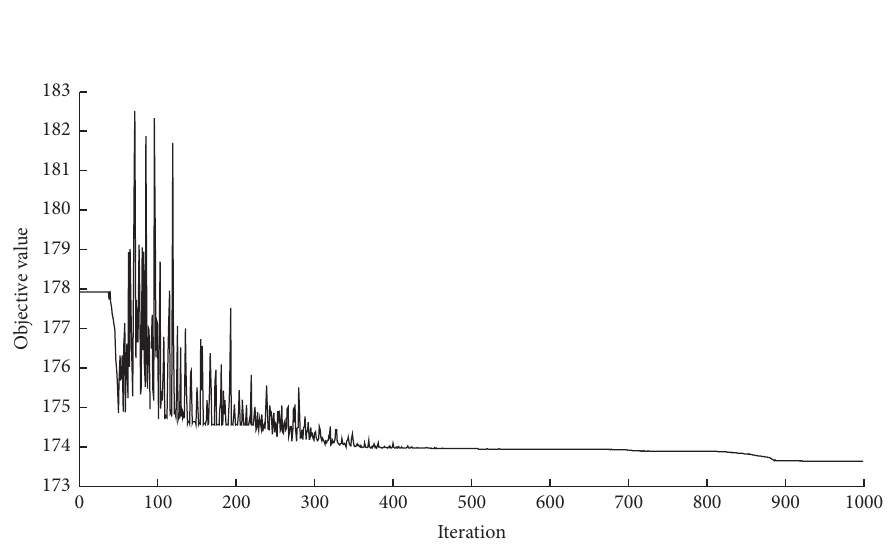
Figure 3: The evolution process of GA.